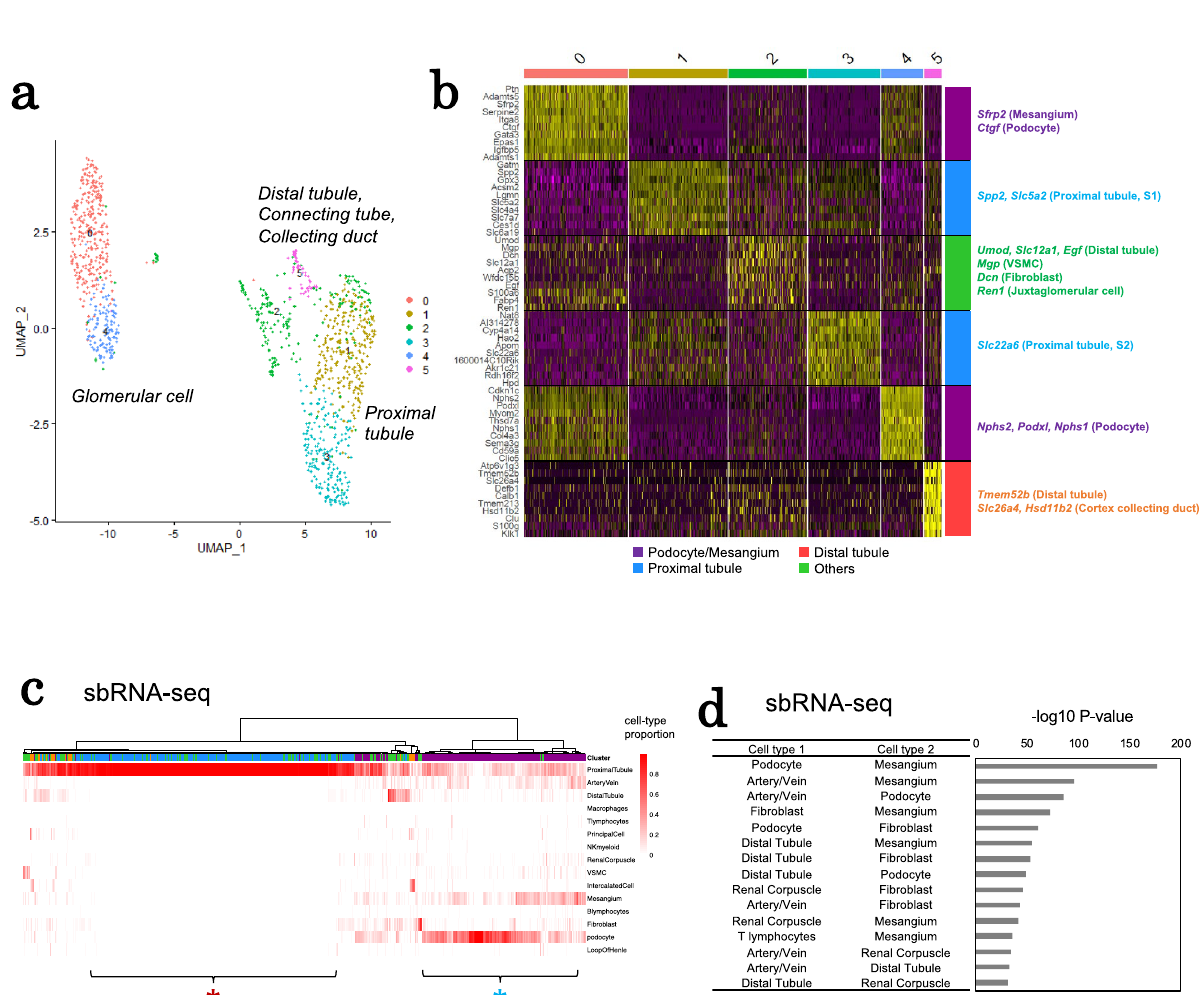
Figure 3. Evaluation of sbRNA-seq using mouse tissues. ( a ) A UMAP plot of 1158 sbRNA-seq datasets generated by Seurat 24 . Six clusters are shown in each color. ( b ) A heatmap of differentially expressed genes in each cluster of ( a ). Representative cell-type markers manually represented in the margin. The heatmap was prepared using Seurat. ( c ) Cell-type proportions of mouse kidney sbRNA-seq inferred by CIBERSORTx 25 . The upper color keys show semibulk classifications manually annotated from cell-type markers in ( b ). The heatmap of cellular-type proportions was prepared using pheatmap of R. ( d ) Probabilities of co-occurrence of two cell types in sbRNA-seq datasets. The hypothesis test of independence of cell-type pairs was conducted. The horizontal bar plot shows the − log 10 P-value of the top 15 pairs of cell types with the lowest